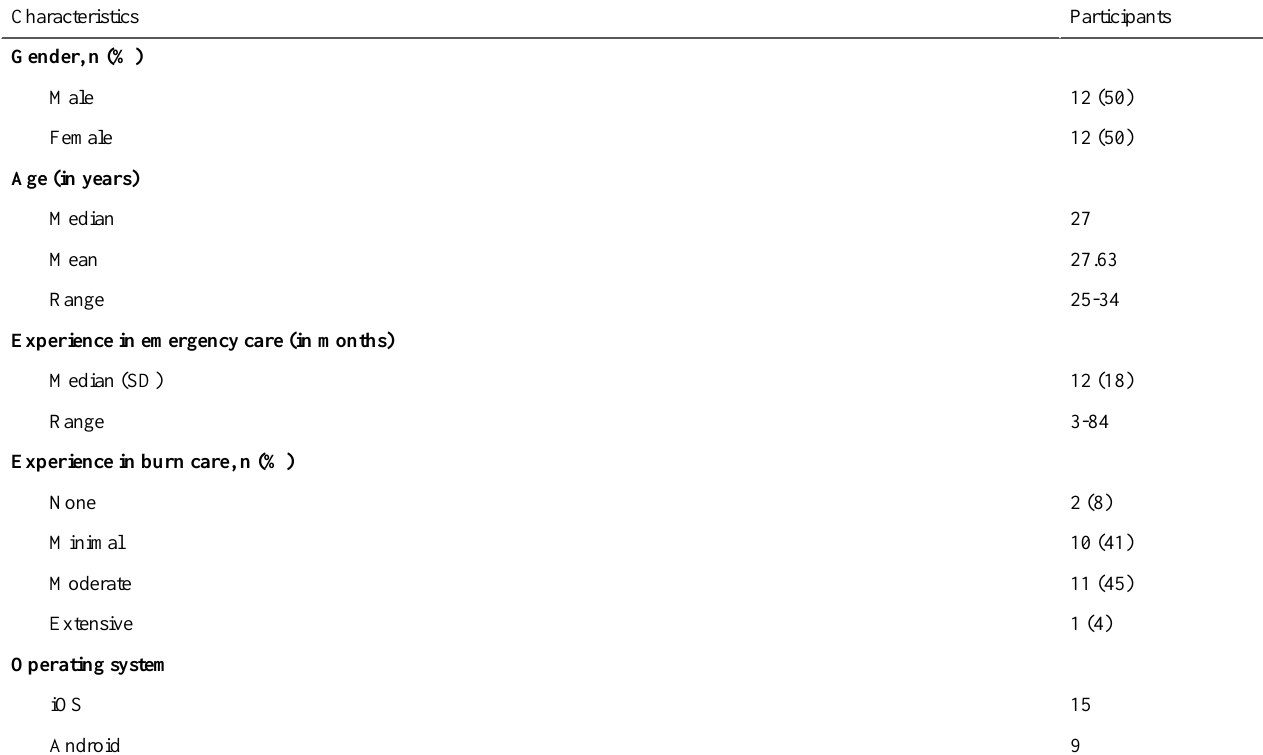
Table 4. Demographics of study participants